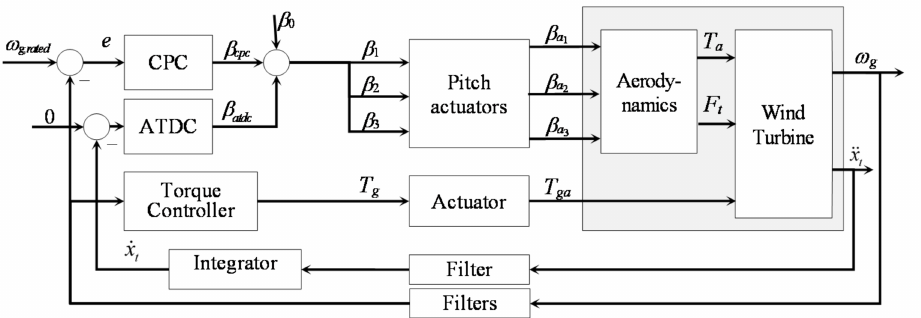
Figure 7. Control system configuration including an active tower damping control